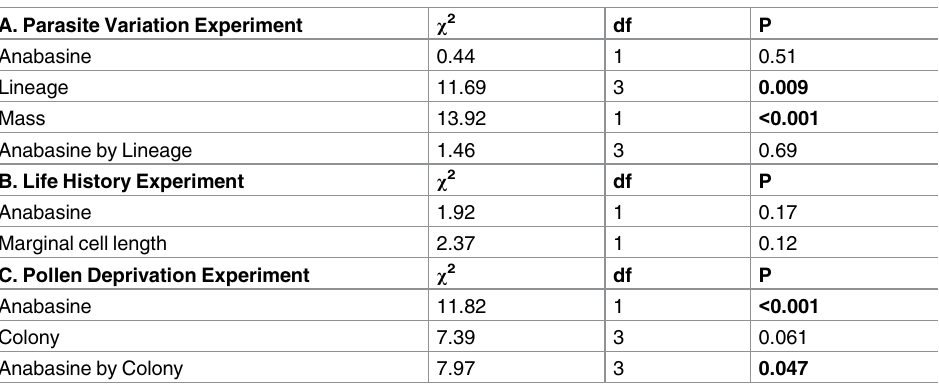
Table 1. Effects of 5 ppm anabasine treatment on Crithidia infection intensity in Bombus impatiens across three experiments. (A) Parasite VariationExperiment that tested effects of anabasine on infection of individual bees with one of four Crithidia lineagesand reared individually.(B) Life History Experiment in which bees were reared in microcolonies of three workers. (C) PollenDeprivation Experimentin which individual bees were deprivedof pollen. Significance of terms in generalized linear mixed-effectsmodels were tested by χ 2 tests. Crithidia cell counts were ln(x+1)-transformed to better conform to model assumptions. Marginal cell length refers to length of the right forewingmarginalcell, used to estimate bee size (see Materials and Meth- ods). Colonyrefers to the bee’s experimental colony of